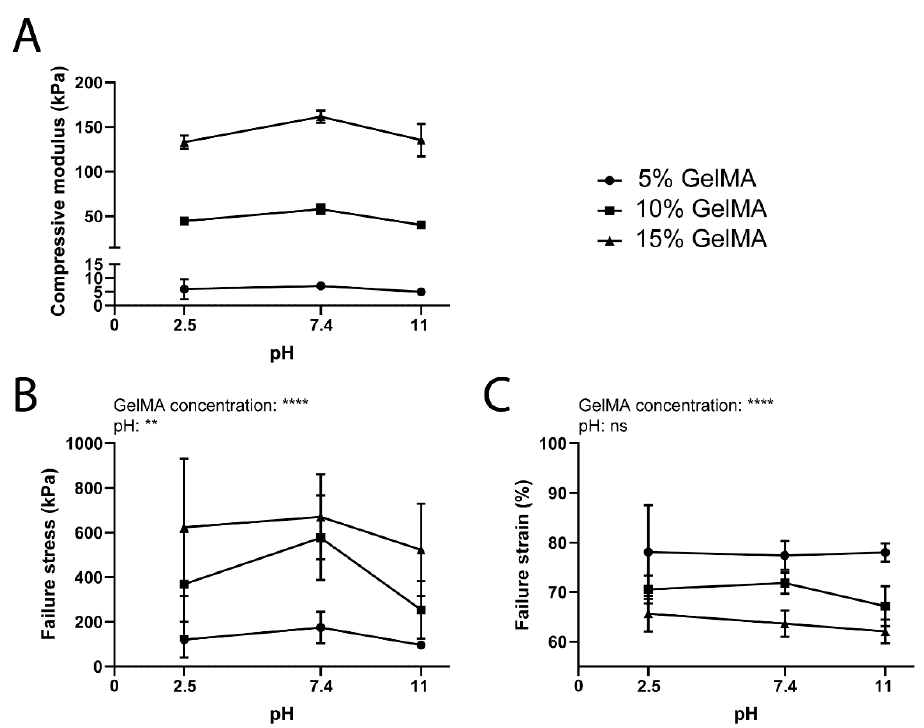
Figure 9. Mechanical properties for GelMA hydrogels (5% to 15% gel fraction) swelled at different pH. ( A ) Compressive modulus. ( B ) Failure stress. ( C ) Failure strain. Data are shown as means ± standard deviation, n = 6–8. ** = p < 0.01; **** = p < 0.0001.